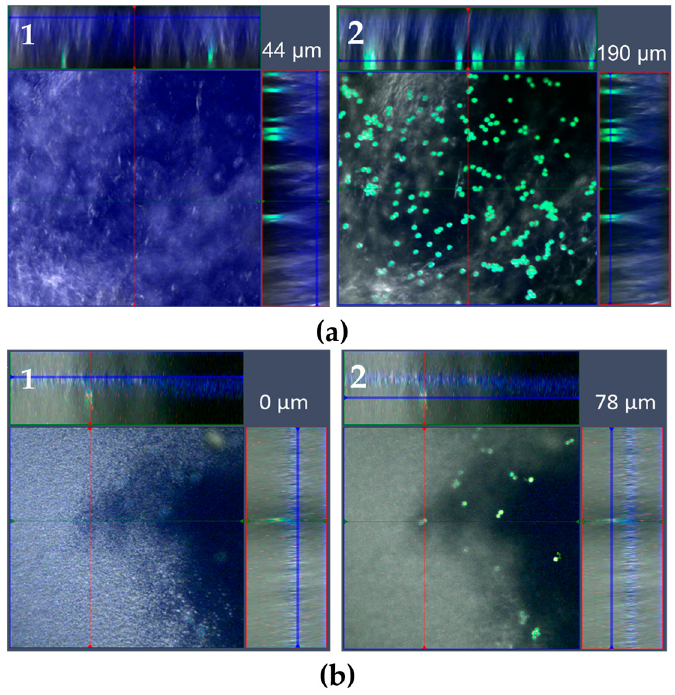
Figure 4. Pollen deposition of the Iva xanthiifolia (z-stack by CLSM). ( a ) Iva xanthiifolia deposited via VPC on petrolatum. Image 1 shows the focus area of the ointment beginning with a high of 44 µm by performing the z-stack. Image 2 on the right shows the focus area of the pollen (green), which is the last area in which ointment is localized (190 µm). Consequently, no penetration of pollen was observed. The blue scattered light from the laser further stresses the thickness of the ointment. ( b ) Bepanthen ® Eye and Nose Ointment via CLSM. Image 1 indicates the first focus level of the Bepanthen ® Eye and Nose Ointment on the cover slip, image 2 demonstrates the second focus level on the top of the Bepanthen ® Eye and the Nose Ointment with deposited pollen. The images were selected from a z-stack, which emphasizes the limited fluorescence signal of pollen in the ointment. The ointment (beginning left, 0 µm) and pollen on top (right, 78 µm) highlight both limiting imaging points.